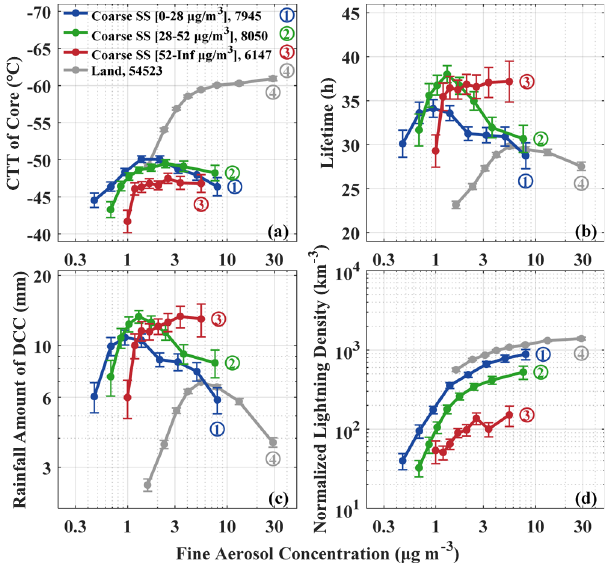
Fig. 3 Relationship between deep concective cloud (DCC) properties and fi ne aerosols for three fi xed bins of coarse sea salt (CSS) aerosols over ocean. The DCC properties are: a cloud top temperature (CTT) of core, b lifetime, c rainfall amount, and d normalized lightning density by rainfall amount throughout the DCC lifetime. The gray lines are for DCC over land, replicating the green lines of Fig. 2. The I-type vertical bars indicate standard error. The same percentile of 5%, 15%, 30%, 50%, 70%, 85%, 95%, 100% for fi ne aerosol bins are used over ocean,